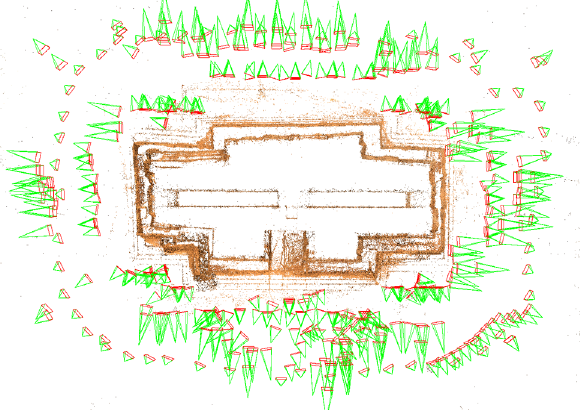
Figure 3. Displaying the position of the pictures At this stage of the process, we have the spatial location of all the pictures and we can continue following two different strategies to generate the results, one for the orthophotos and the other to get the 3D